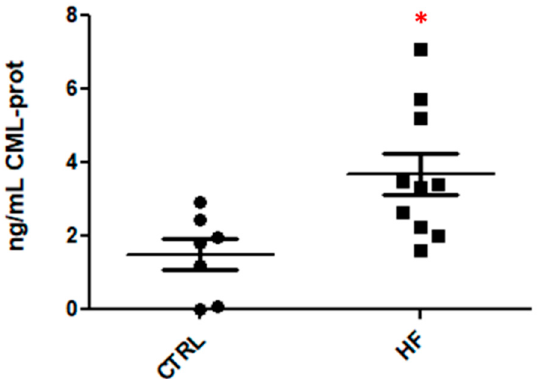
Figure 7. Measurement of CML-adducted protein content by ELISA; Statistical analysis: unpaired t-test ( p value 0.0122). (* p-value summary)